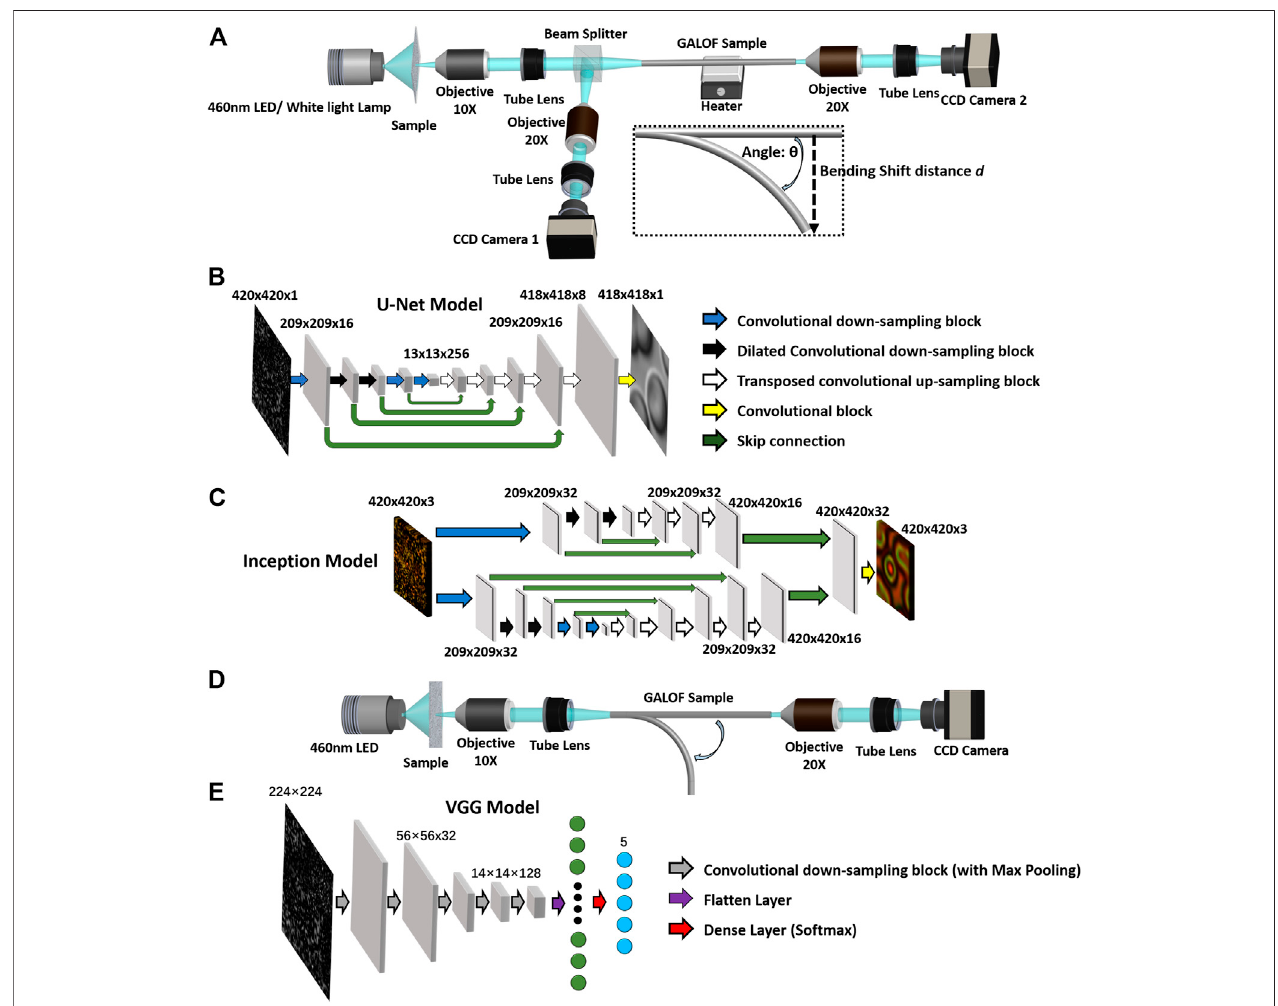
FIGURE7|(A) Schematic ofthecellimagingsetup.Thelightsourcecanbe eithera460-nmLEDorawhitelightlamp.TheLED servesforgray-scaleimaging.The white light lamp is used for color imaging. The sample is illuminated under transmission mode. The image of the sample is relayed through the 4f system consisting of a 10 × objective and a tube lens. The relayed image is split into two copies: one is recorded by camera 1, working as the reference image (ground truth); the GALOF samples the other one for generating raw image purpose. The fi ber-sampled image is transported through a meter-long GALOF sample ( ∼ 80 cm) and fi nally recorded by camera 2. The data collected by camera two is the raw images. A heater is attached at the center of the GALOF sample to increase the fi ber temperature. The imaging process is tested under both straight and bent fi ber status. As shown in the inset, the input end of the GALOF is fi xed while the output end is bent by a bending shift distance d . The relation between the bending angle θ and the bending shift distance d is given by d (cid:2) L[1-cos( θ )]/ θ , (B) The architecture of the DCNN for gray-scale cell image reconstruction based on aU-Net framework. The image is adapted withpermission from [19]. More details refer to[19], (C) The architecture ofthe DCNN for color cell image reconstruction is based on an inception CNN framework. The image is adapted with permission from [134] © The Optical Society, (D) Schematicofthecellrecognitionsetup.Thedesignofthesetup (D) issimilartothesetupin (A) ,exceptthatthebeamlineforreferenceimagecollectionisremoveddueto its imaging-free capabilities. The setup justcollects theraw speckleimages for classi fi cation purposes.Similar tothe insetshown in (A) ,the imagingrecognitionprocess is also tested under bent fi ber status with the same bending mechanism. More details refer to [52]. (E) The architecture of the DCNN for cell recognition is based on a VGG framework. More details refer to